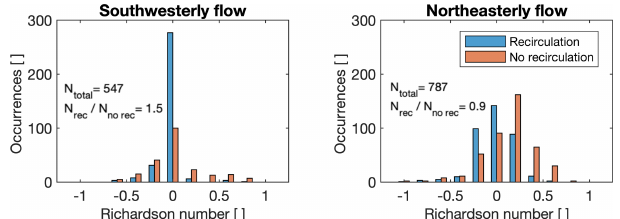
Figure 6. Recirculation occurrence as a function of the Richardson number. The results are presented in bins with a width of 0.2. Data from all three transects are presented together, segregated by the wind